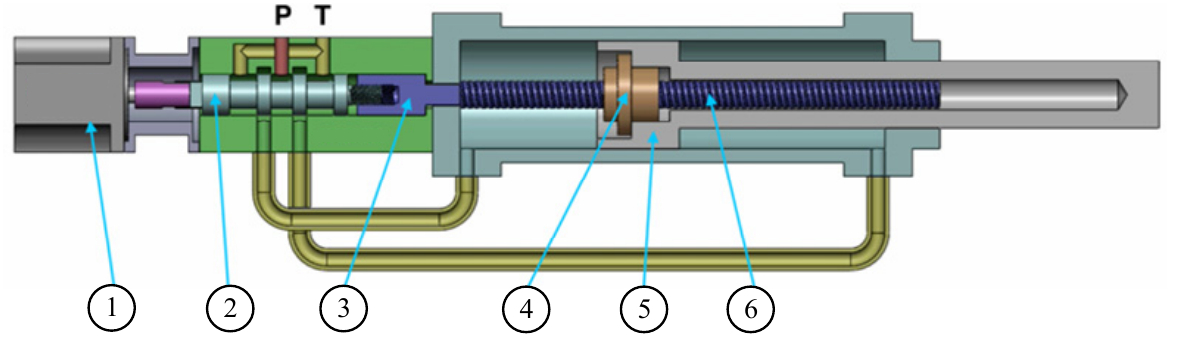
Figure 2. Structure diagram of a digital hydraulic cylinder. 1. Electrically controlled stepping mo- tor/servo motor; 2. Valve spool; 3. Nut bushing; 4. Nut; 5. Rod; 6. Screw stem.